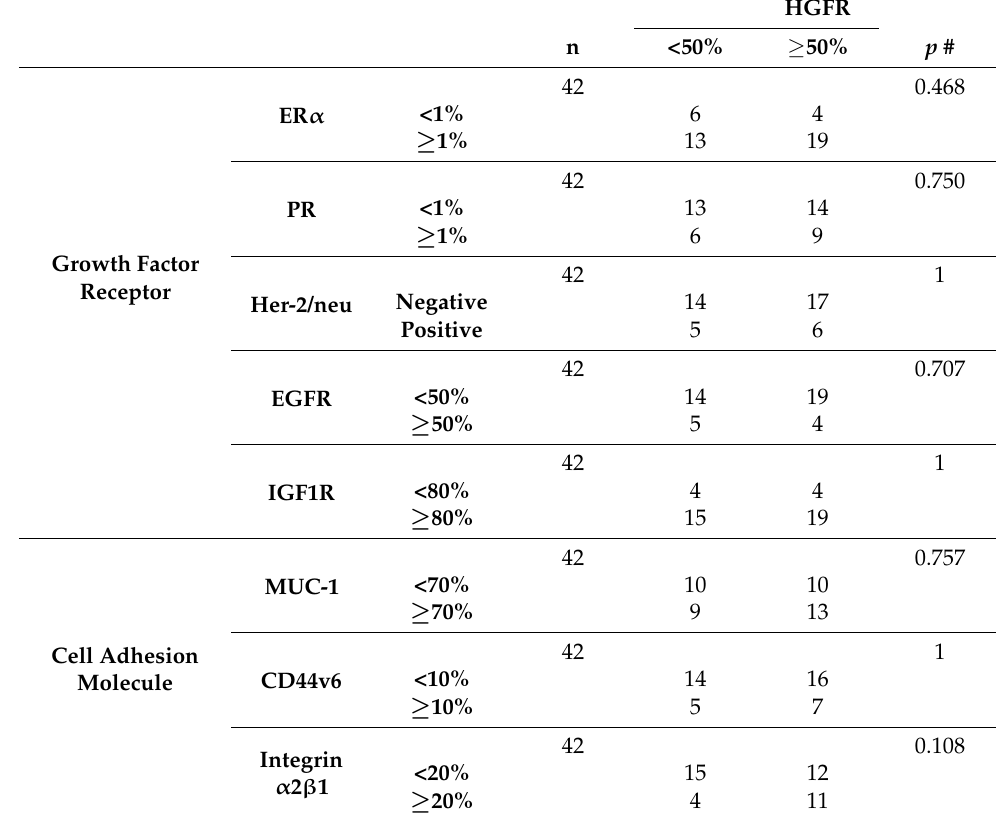
Table 4. Correlation between HGFR expression and other protein biomarkers.